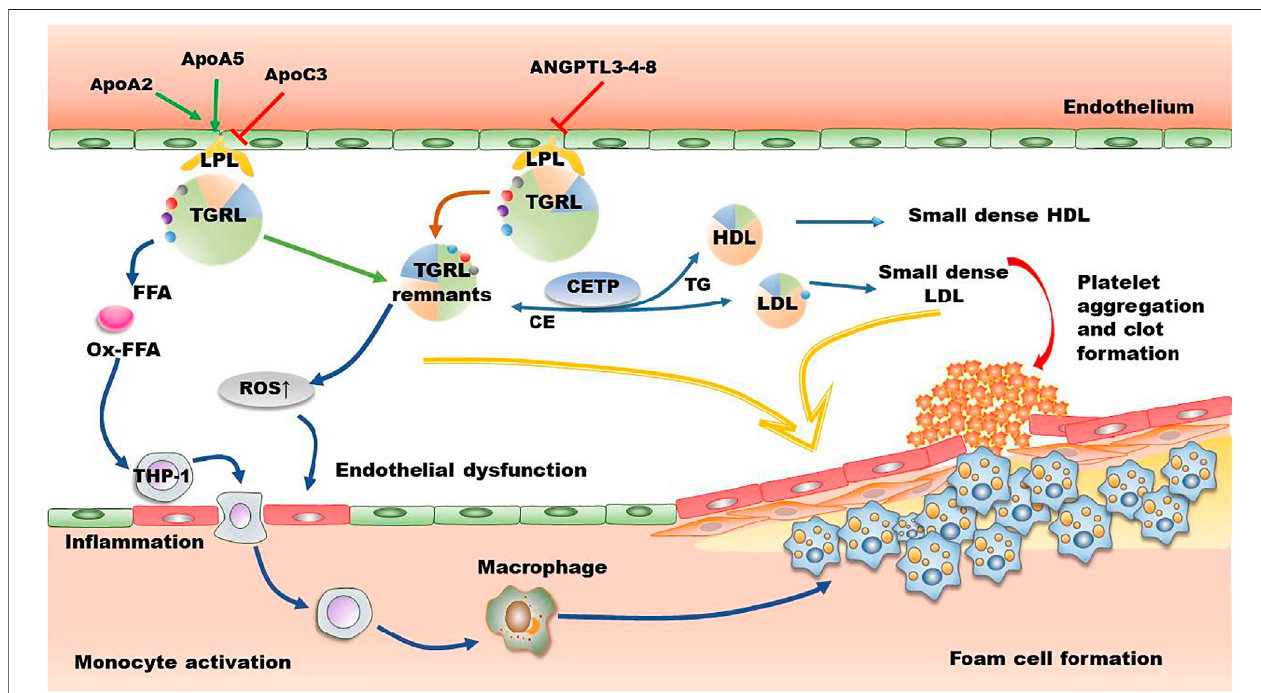
FIGURE2| ThemechanismsofTGRLonpromotingatherosclerosis.Incirculation, apoAIIandapoAVenhancetheactivityofLPL,whileapoAIIIandANGPTL3-4-8 suppressLPL-inducedTGRLlipolysis.However,severalstudiesdemonstratethatapoAIIIhasnoeffectontheactivityofLPL.Thereleased FFAandthelipolysisprocess promote the production of ROS and secretion of in fl ammatory factors, leading to endothelial dysfunction and formation of foam cells. CETP-mediated lipid exchange between TGRL and HDL/LDL increases the production of small dense LDL and small dense HDL, further promoting deterioration of atherosclerosis. Furthermore, lipolytic products activate platelet and induce clot formation. ANGPTL, angiopoietin-like protein; Apo, apolipoprotein; CE, cholesteryl ester; CETP, cholesteryl ester transport protein; FFA, free fatty acid; HDL, high density lipoprotein; LDL, low-density lipoprotein; LPL, lipoprotein lipase; Ox-FFA, oxidized FFA; ROS, reactive oxygen species; TG, triglycerides; TGRL, triglyceride-rich